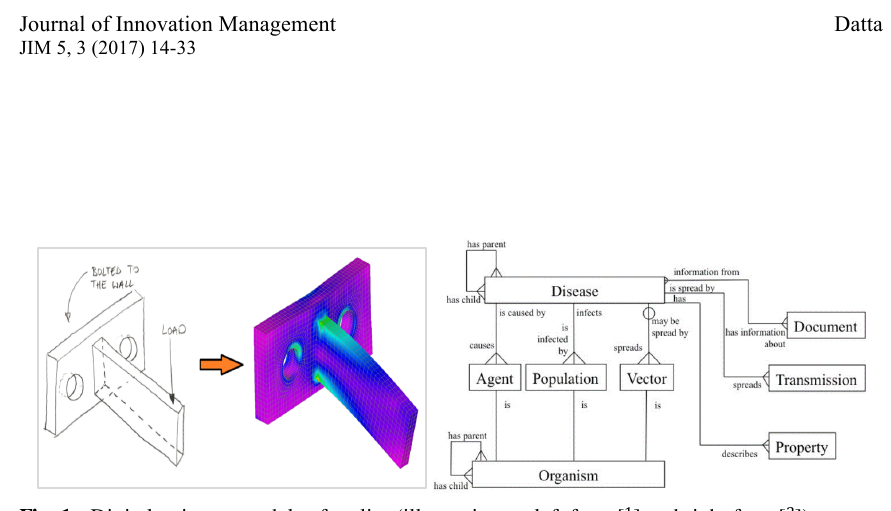
Fig. 1 - Digital twins as models of reality (illustration on left from [ 1 ] and right from [ 2